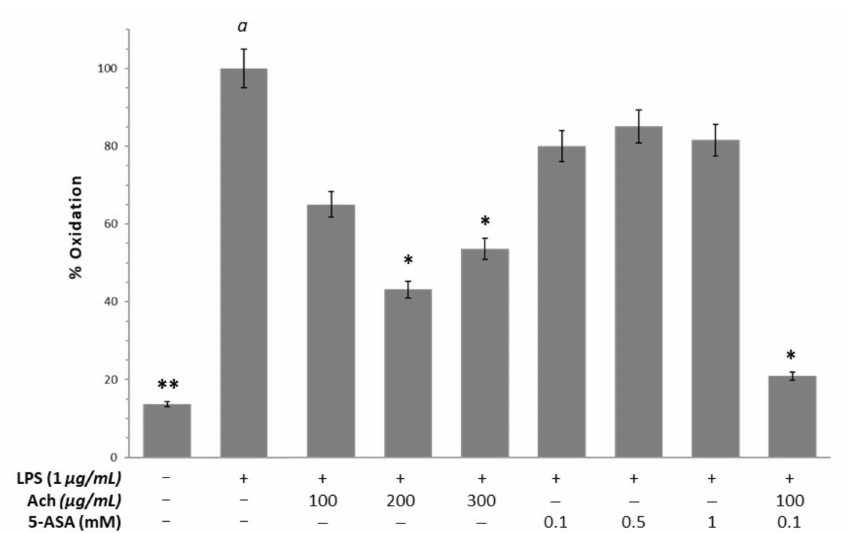
Figure 6. Ach inhibits oxidative stress in RAW 264.7 macrophages stimulated with LPS (1.0 µ g/mL). The cells incubated with Ach (100 µ g/mL) plus 5-aminosalicylic acid (5-ASA) (5 mM) presented the lowest percentage of oxidation. Data are expressed as the mean ± SEM and the measured percent oxidation were expressed as a percentage from the positive control (cells induced by H2O2). * A p -value < 0.05 and ** p -value < 0.01 indicate significant differences with respect to a . Positive sign (+): presence of treatment; negative sign ( − ): absence of